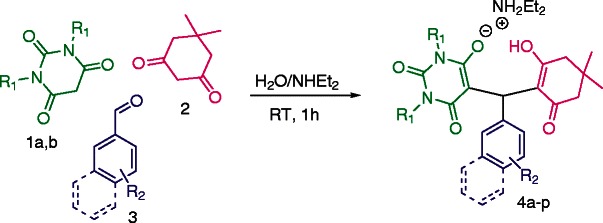
Synthesis of 4a-p.